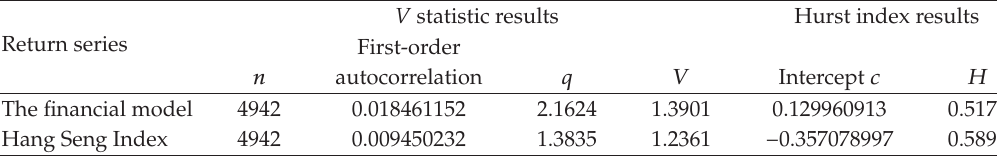
Table 3: Statistics of returns for V and H